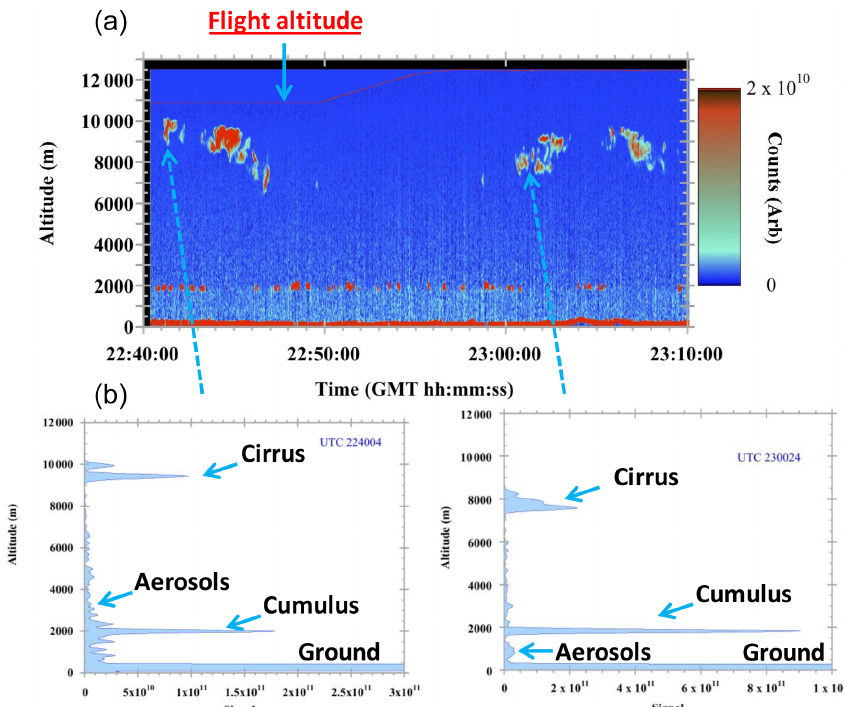
Figure 1. A 30min long vertical cross section (a) and two individual 1s vertical profiles (b) of atmospheric backscattering at offline wave- lengths of CO 2 line measured by NASA GSFC CO 2 Sounder near the West Branch, Iowa, tall-tower site on 11 August 2011. The backscatter signals were corrected by square of range and averaged by 1µs vertical running mean ( ∼ 150m) and 1s horizontal running mean (200m of ground track). Returns from ground, cumulus and cirrus clouds, and aerosols are illustrated and labeled.